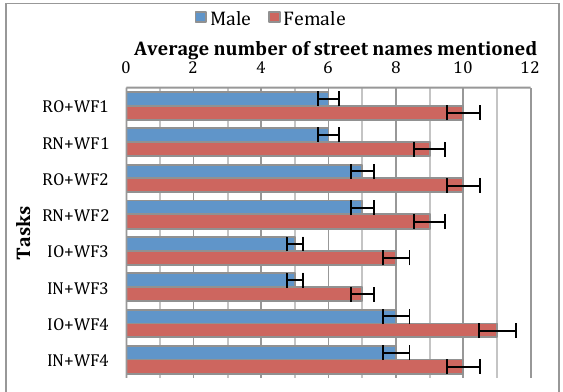
Figure 4. Average number of street names mentioned